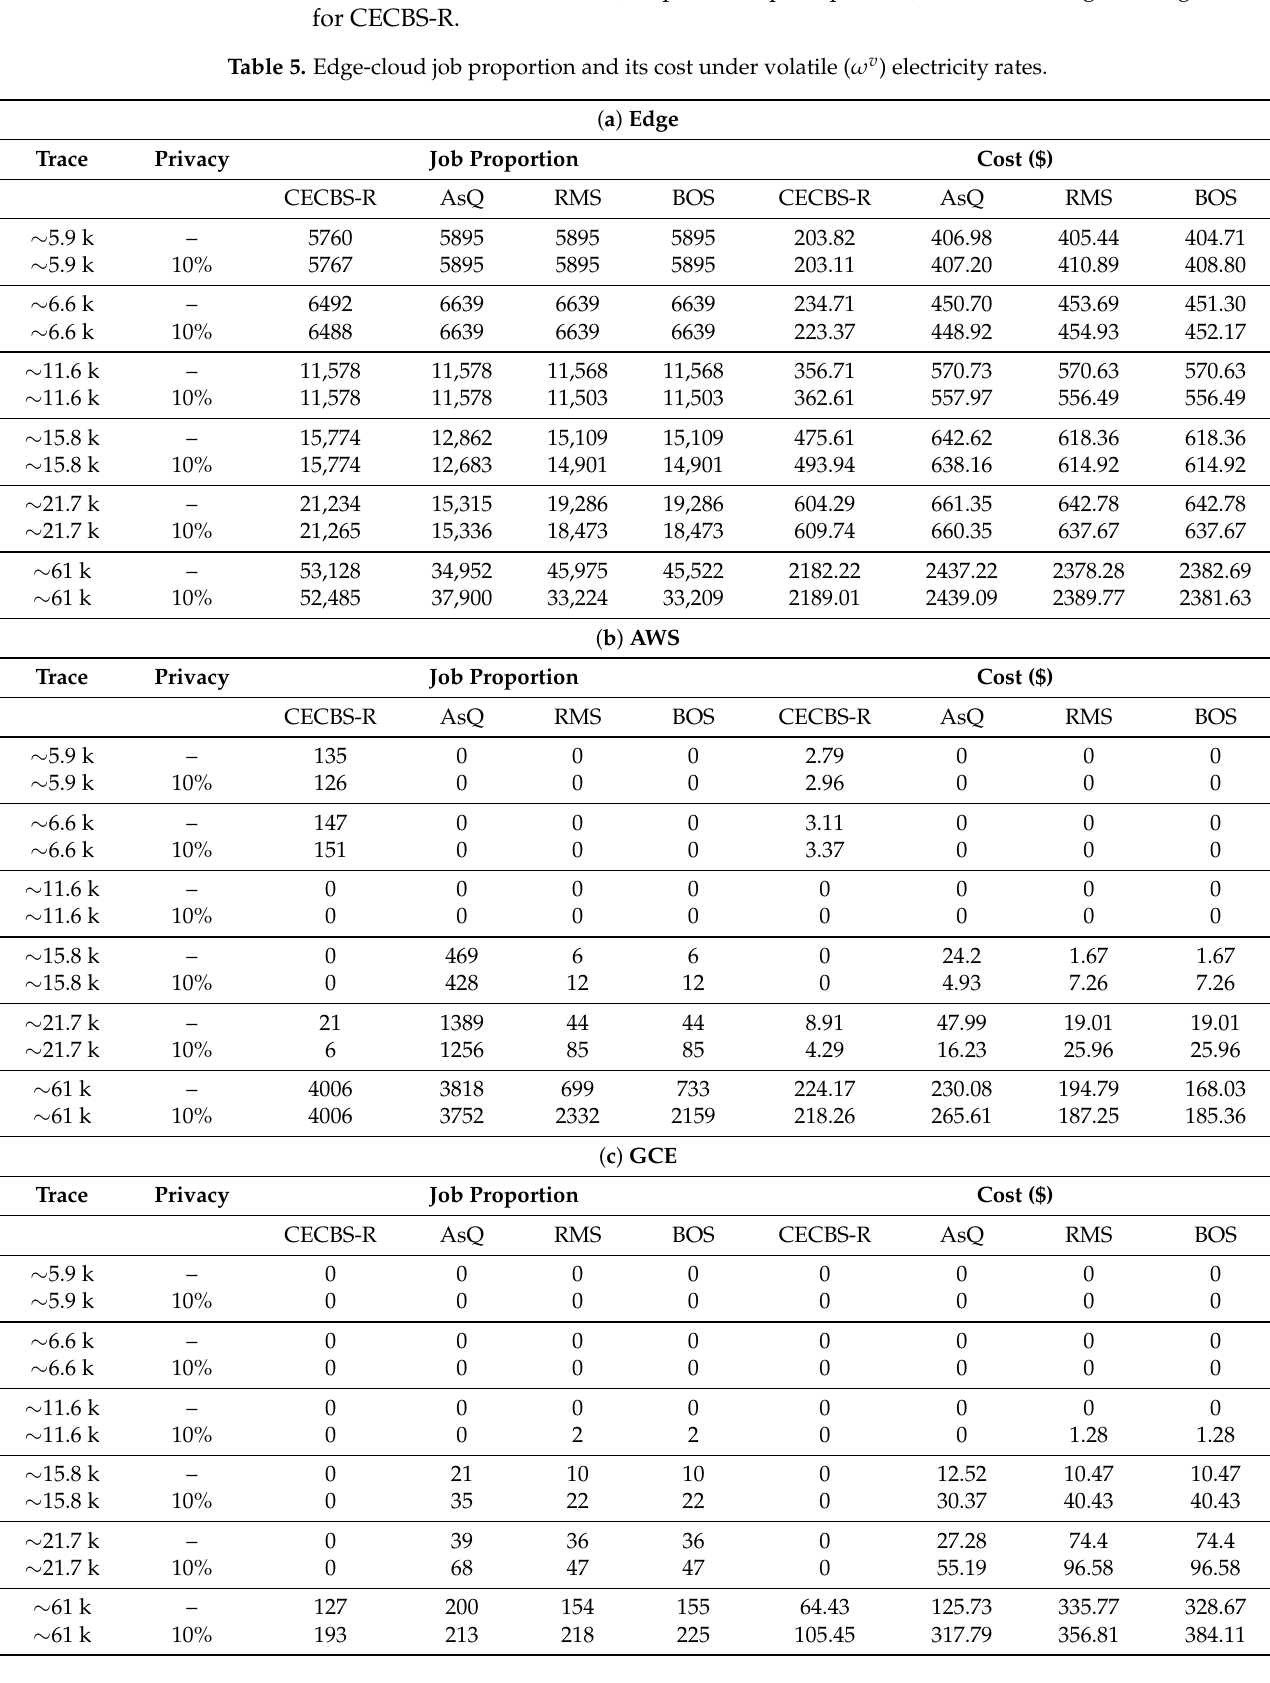
Table 5. Edge-cloud job proportion and its cost under volatile ( ω v ) electricity